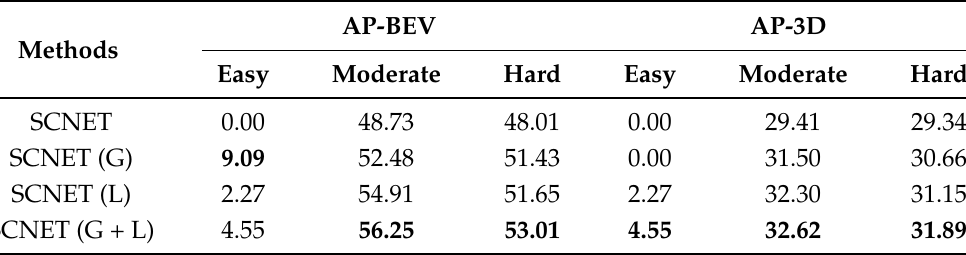
Table 2. The object detection performance of our method. G denotes the global feature adaptation, and L denotes the subcategories instance adaptation.